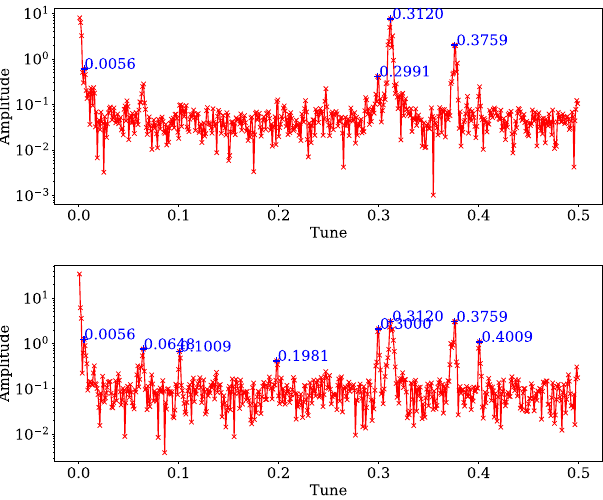
FIG. 20. Frequency analysis of the raw signal (Fig. 19) for bunch 4 (top) and bunch 5 (bottom) indicating local maxima in the region of the measured (BBQ) betatron tunes Q x ¼ 0 . 30 and Q ¼ 0 . 31 y